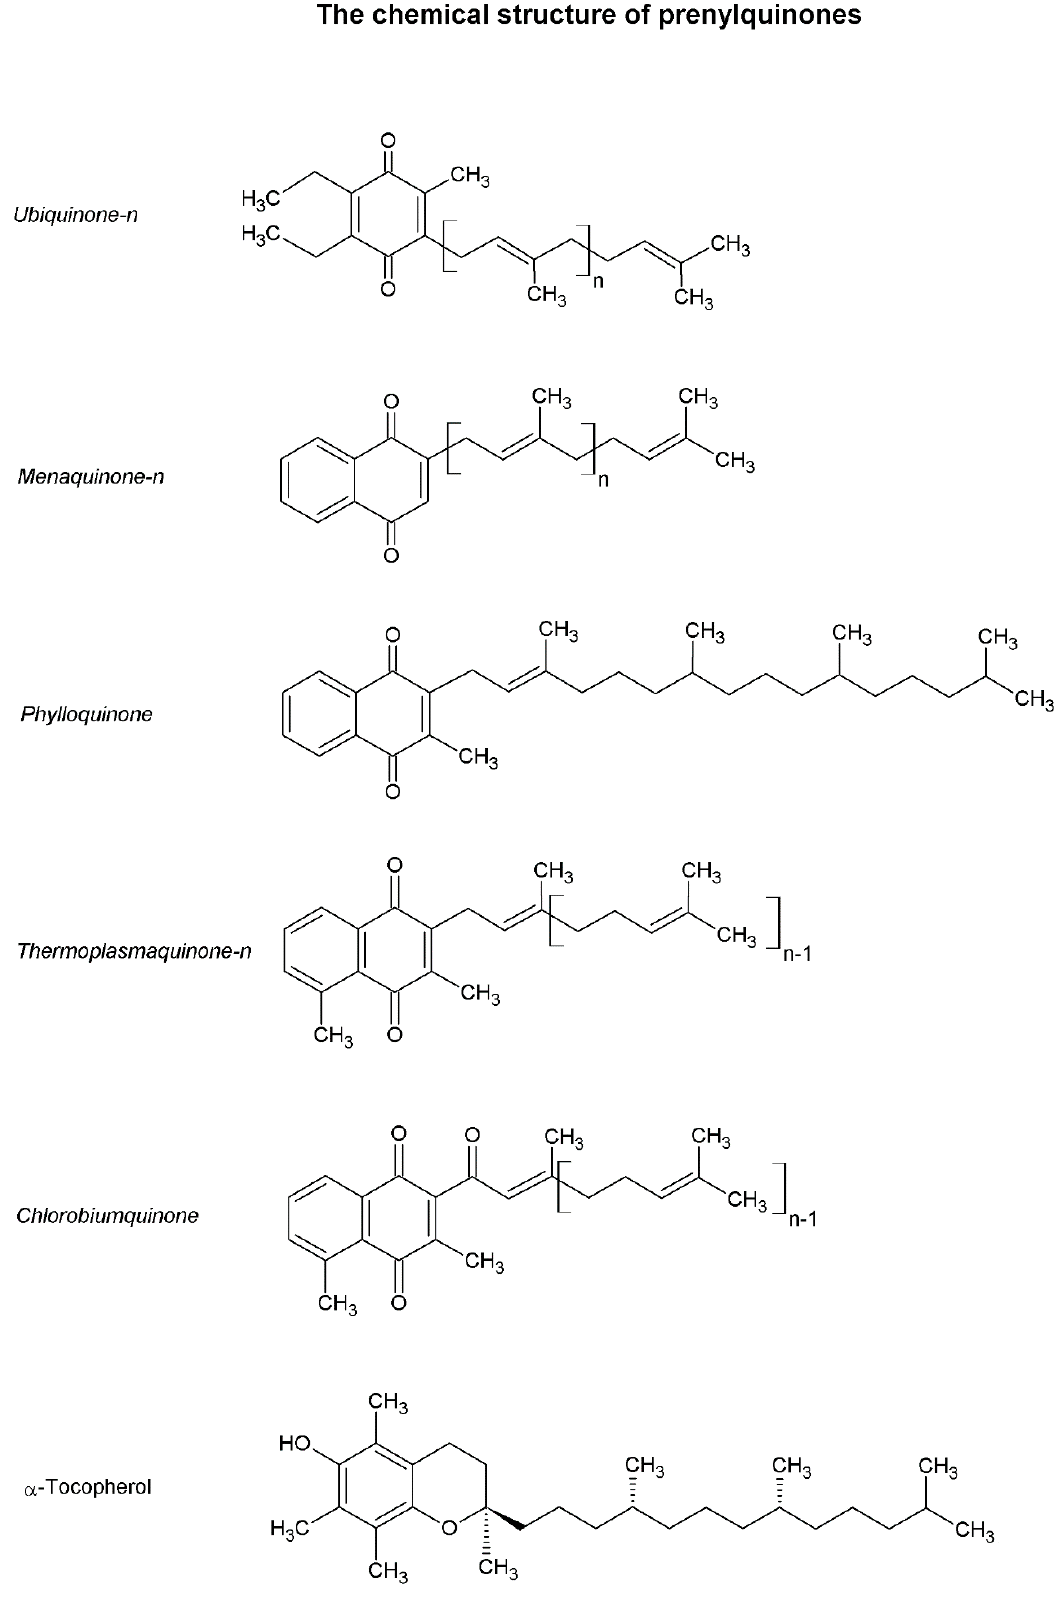
Figure 1. The chemical structures of prenylquinones. The figure shows the chemical structures of prenylquinones already characterized in pathogenic protozoa. n indicates the variable related to the isoprenic units contained on the prenylquinone side chain. Structures designed using ACD/ChemSketch, version 12, Advanced Chemistry Development, Inc., Toronto, ON, Canada.